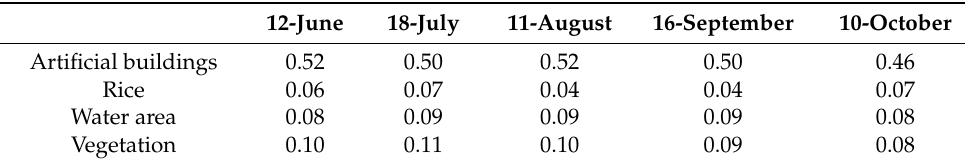
Table 3. Coherence coefficient of ground objects of VV